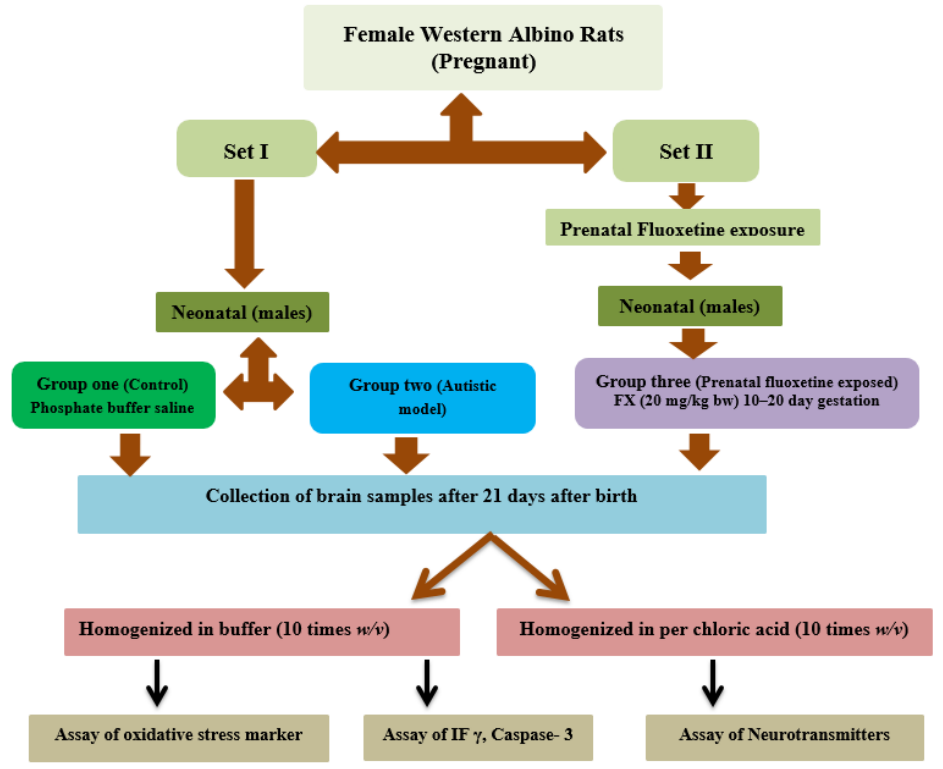
Figure 1. S chematic representation of the different groups with treatment involved in the